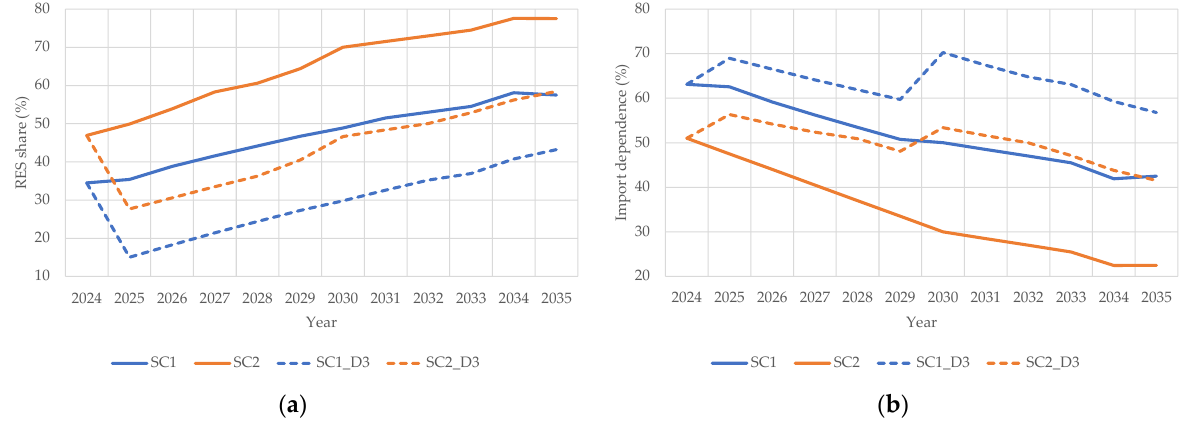
Figure 8. Resilience indicators in the case of the loss of biomass supply: ( a ) RES share; ( b ) import dependence.